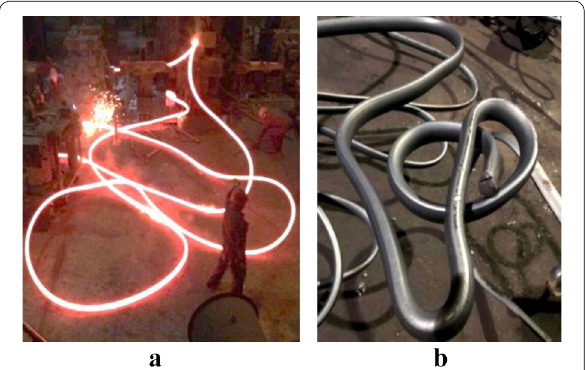
Figure 6 A producing accident: wire rod pushed toghter and crowded out of the passing line, caused by speed relationship mismatched: a wire rod out of the passing line; b the pushed toghter and crowded wire